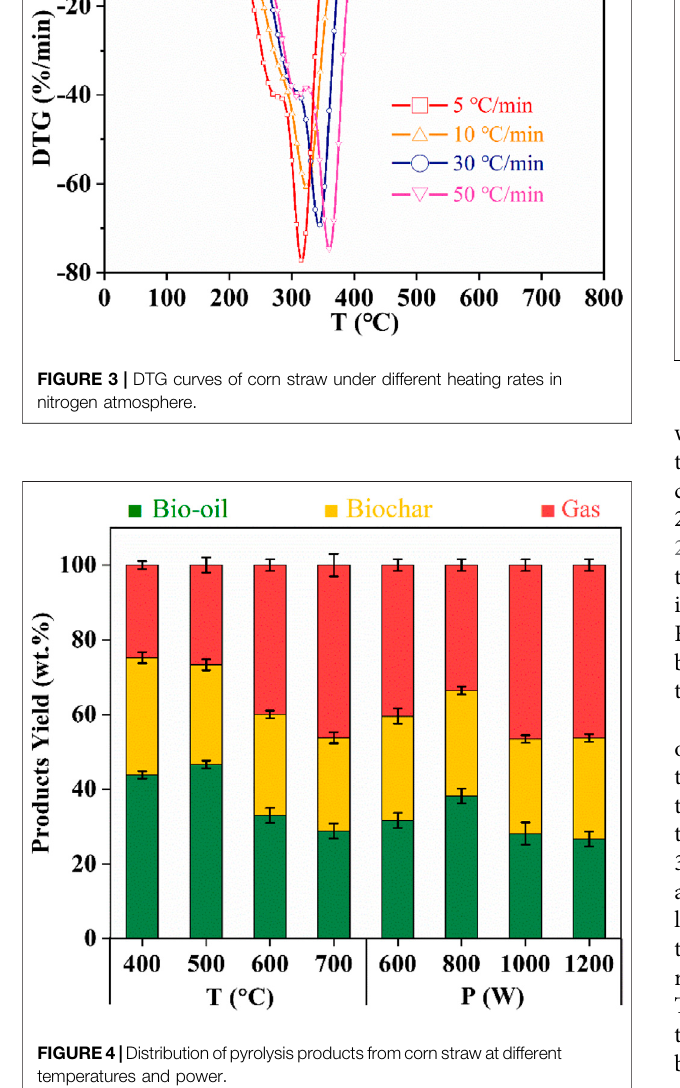
Frontiers in Chemistry |